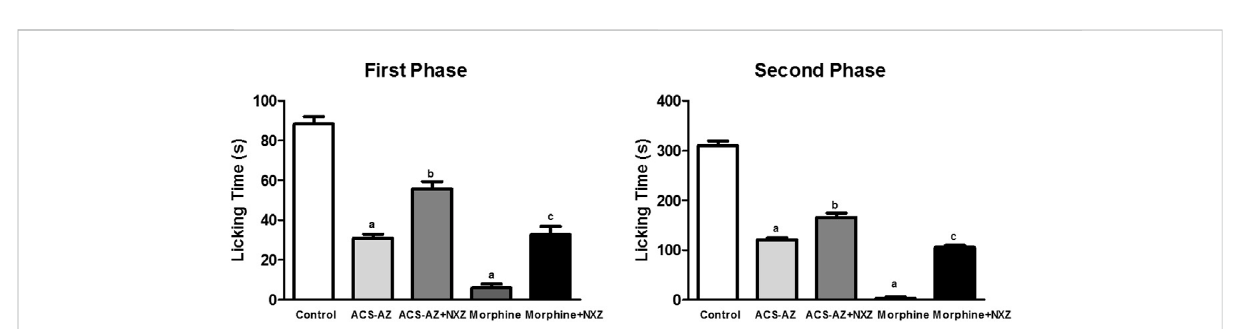
FIGURE 11 Effectofpretreatmentwithnaloxonazine(10 mg/kg)onantinociceptionofACS-AZ(50 mg/kg)andmorphine(6 mg/kg),inthe fi rstandsecond phases of formalin-induced nociception. The lick time (seconds) after administration of formalin solution into the mice dorsal surface of the right hind paw was recorded for each animal. The results represent the mean ± SEM ( n = 8) analyzed by one-way ANOVA followed by Tukey test: a p < 0.05 vs. control; b p < 0.05 compared to the group that received only ACS-AZ; c p < 0.05 compared to the group that received only morphine. ACS-AZ: N ’ -(6-chloro-2-methoxyacridin-9-yl)-2-cyanoacetohydrazide; NXZ: